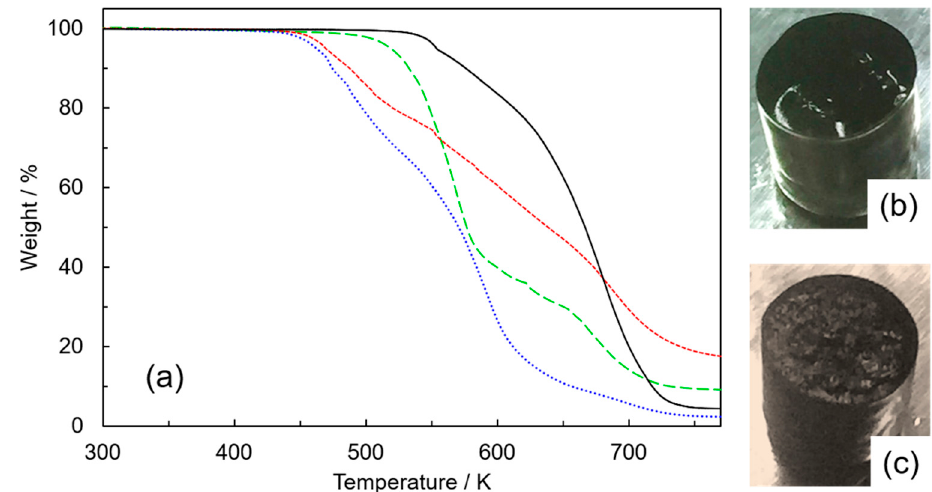
Figure 1. ( a ) Results of TGA measurements of the 1-allyl-1-(oxiran-2-ylmethyl)piperidinium-based organic salts 1 – 4 : ( ― ) 1 , (- - -) 2 , (• • •) 3 , and ( ‒ ‒ ‒ ) 4 . The rate of temperature increase was 5 K min − 1 . Photographs of ionic liquid (IL) 2 after thermogravimetry measurements under ( b ) nitrogen and ( c ) air atmosphere conditions.